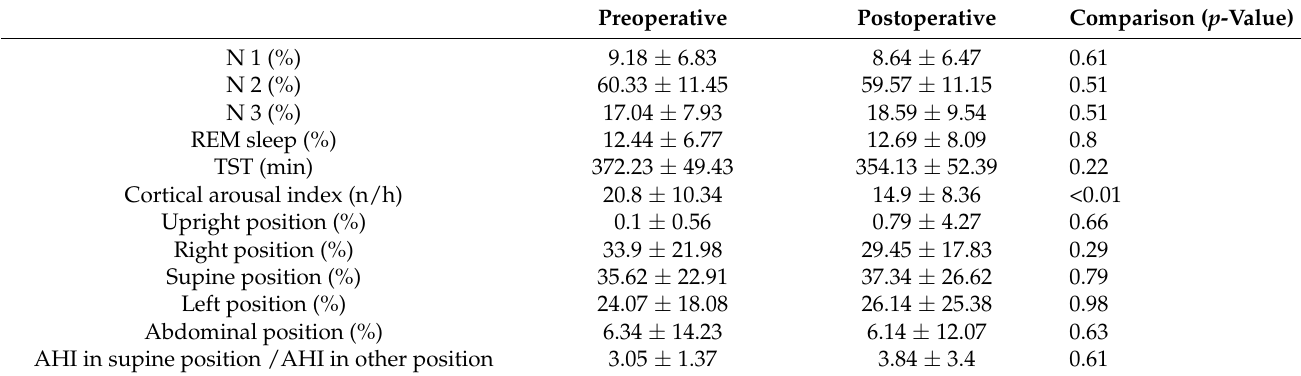
Figure 3. Comparison of arousal index pre-and postoperatively: 20.8 ± 10.34, 14.9 ± 8.36, p < 0.01 **